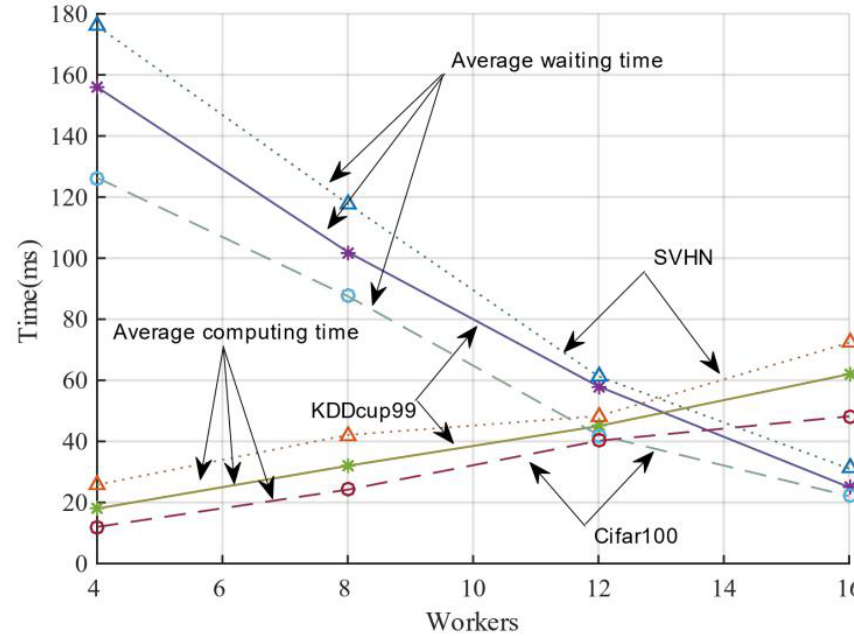
Figure 7. Balance between average waiting time and average computing